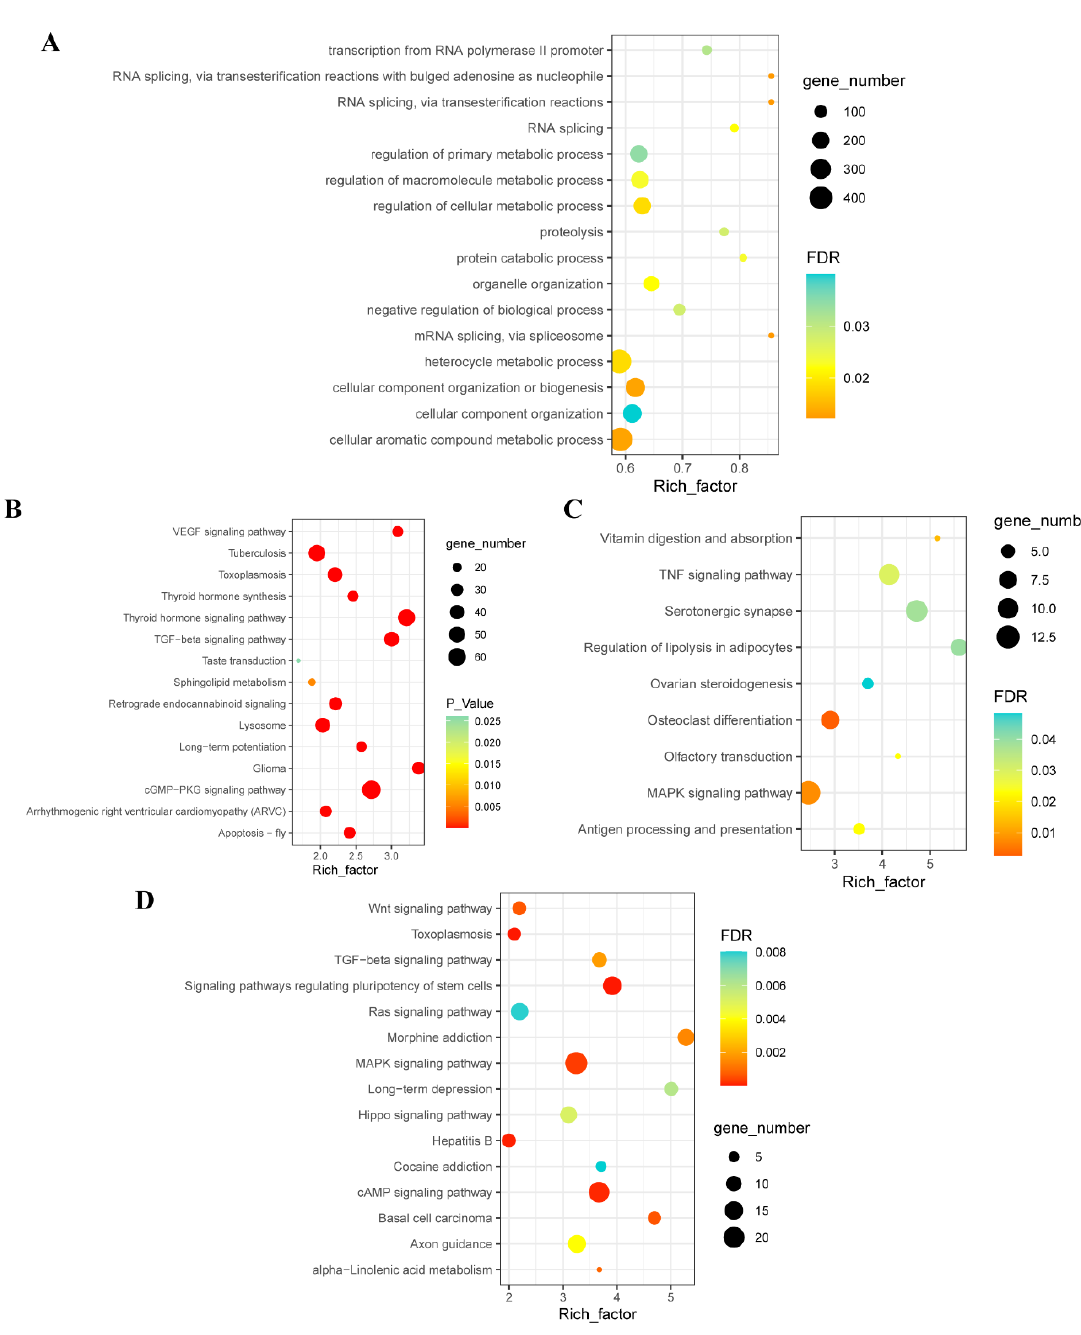
Figure 2. GO biological process and KEGG pathway analysis of group-specific and intersecting m6A-containing genes. ( A ) GO biological process enrichment analysis of the intersection of m6A peak genes and gene expression levels. GO terms with FDR < 0.05 are shown. ( B ) KEGG enrichment analysis of the intersection of m6A peak genes and gene expression levels. The top 15 pathways are shown. ( C ) KEGG enrichment analysis of E19-m6A-peak-associated genes. Pathways with FDR < 0.05 are shown. ( D ) KEGG enrichment analysis of E13-m6A-peak-associated genes. The top 15 pathways are shown.